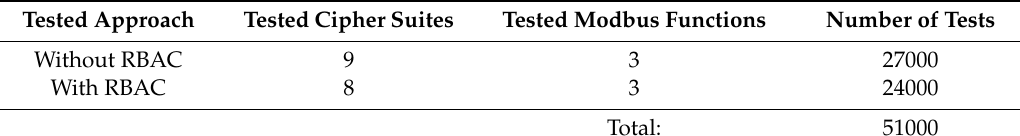
Table 3. Total samples